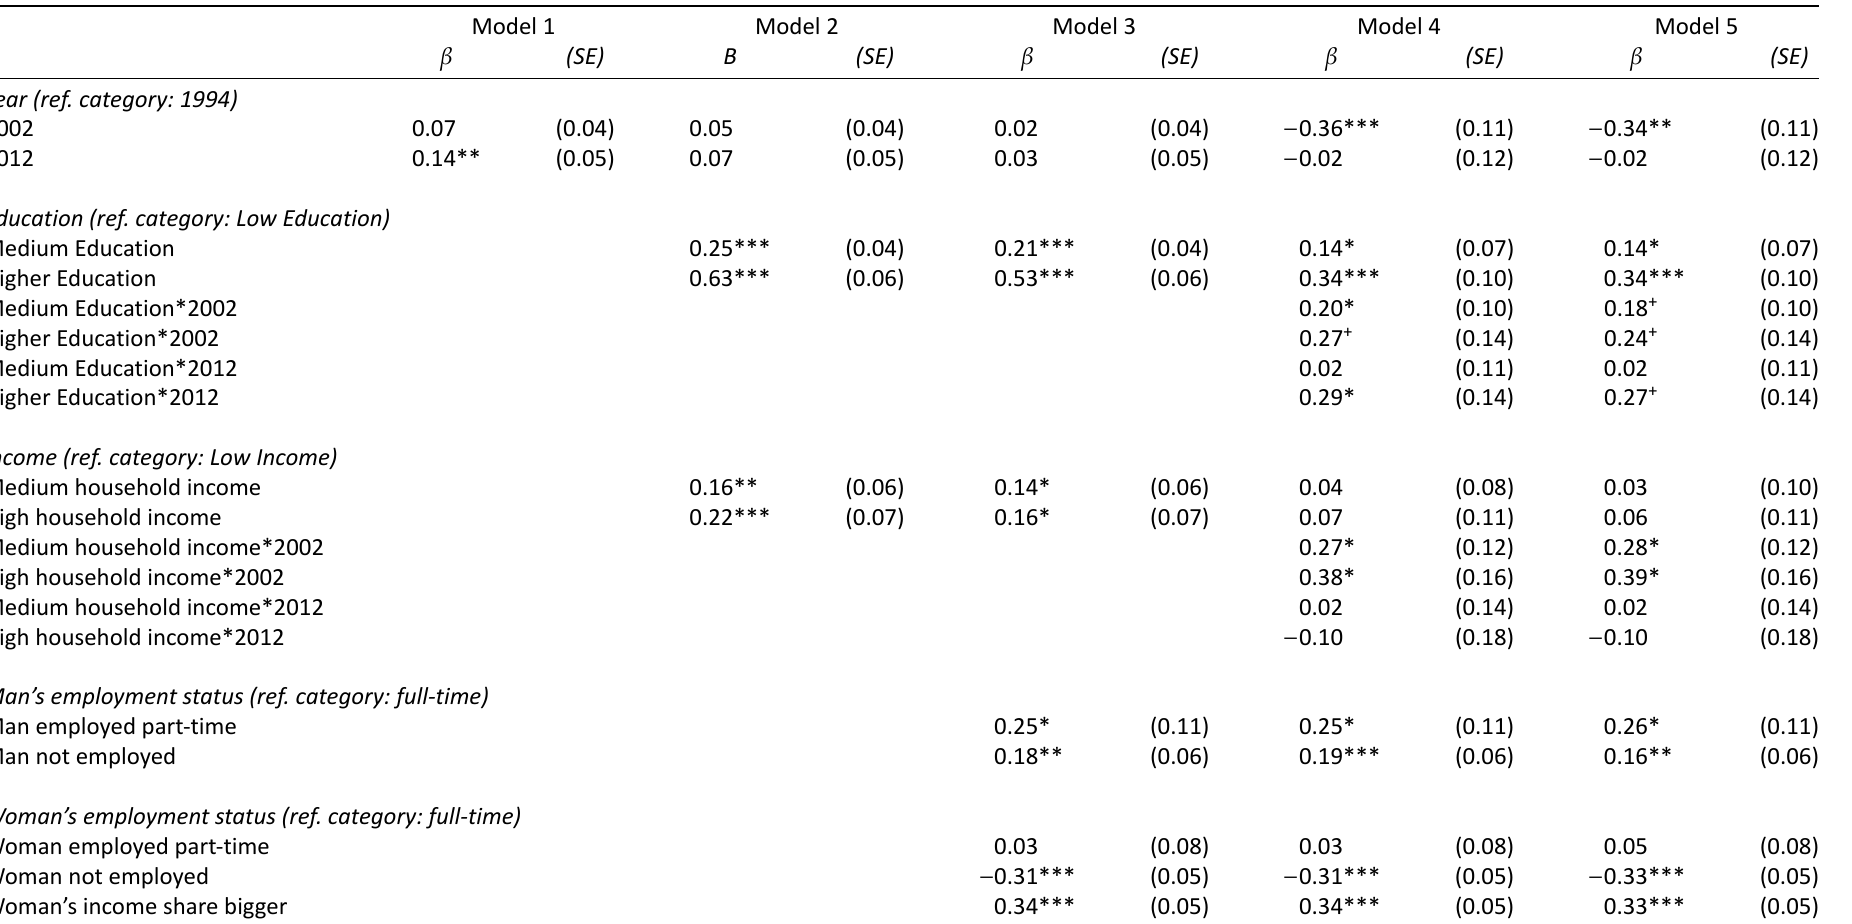
Table 2. Determinants of GDDL, CEE region, 1994–2012 (pooled data,